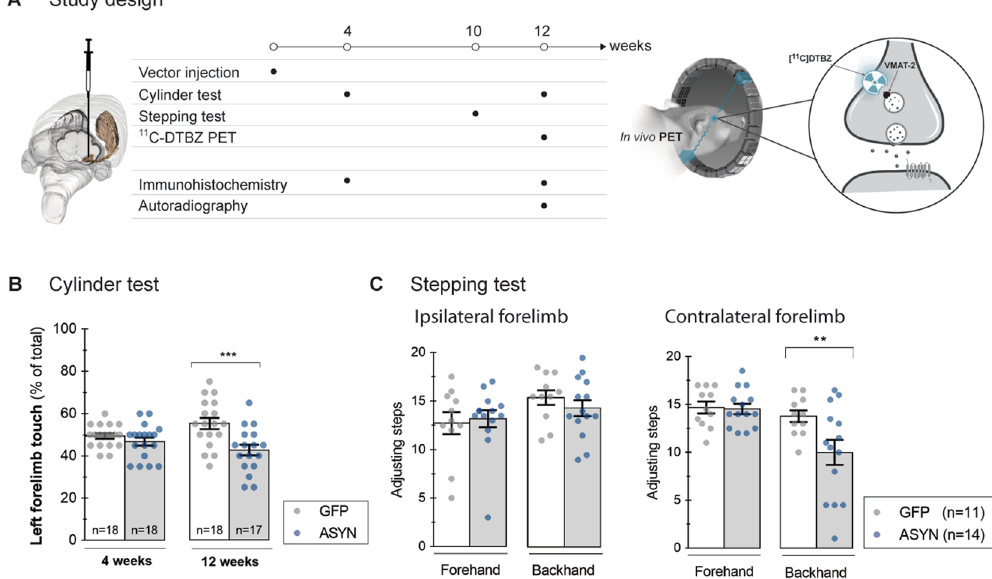
Figure 1. Study design And Motor Performance. The timeline of the study is illustrated in ( A ). Adult rats received a stereotactic unilateral injection of rAAV 2 µ l (1·10 13 gc/ml) in the right ventral midbrain. Motor performance was examined at 4 and 12 weeks after injection with the cylinder test, and the stepping test was done in a separate group at 10 weeks. A group of animals was killed at 4 weeks to evaluate transgene expression and to analyze the dopaminergic system by immunohistochemistry. Animals underwent in vivo [ 11 C]DTBZ PET at 12 weeks and thereafter they were divided in two groups, killed and processed for in vitro autoradiography or for immunohistochemistry in order to correlate in vivo findings with anatomical data. Motor performance evaluated with the cylinder test ( B ) revealed impaired use of the ipsilateral forelimb us at 12 weeks in ASYN animals but not in GFP controls. Two way ANOVA (Interaction time & rAAV F(1, 67) = 5.3 P = 0.02; time effect F(1,67) = 0.14 P = 0.70; rAAV effect F(1,67) = 12.36 P = 0.0008) followed by Sidak’s correction for multiple comparisons. The stepping test was performed at 10 weeks ( C ), and no significant difference in the number of steps was found in the ipsilateral forelimb in any of the groups. However, ASYN overexpressing animals performed significantly less number of steps with the contralateral forelimb in the forehand direction ( C ). Two way ANOVA (Interaction direction & rAAV F(1, 46) = 4.18 P = 0.04; direction effect F(1,46) = 9.43 P = 0.003; rAAV effect F(1,46) = 4.88 P = 0.03) followed by Sidak’s correction for multiple comparisons ** P < 0.01, *** < 0.001. All data are presented as mean ±